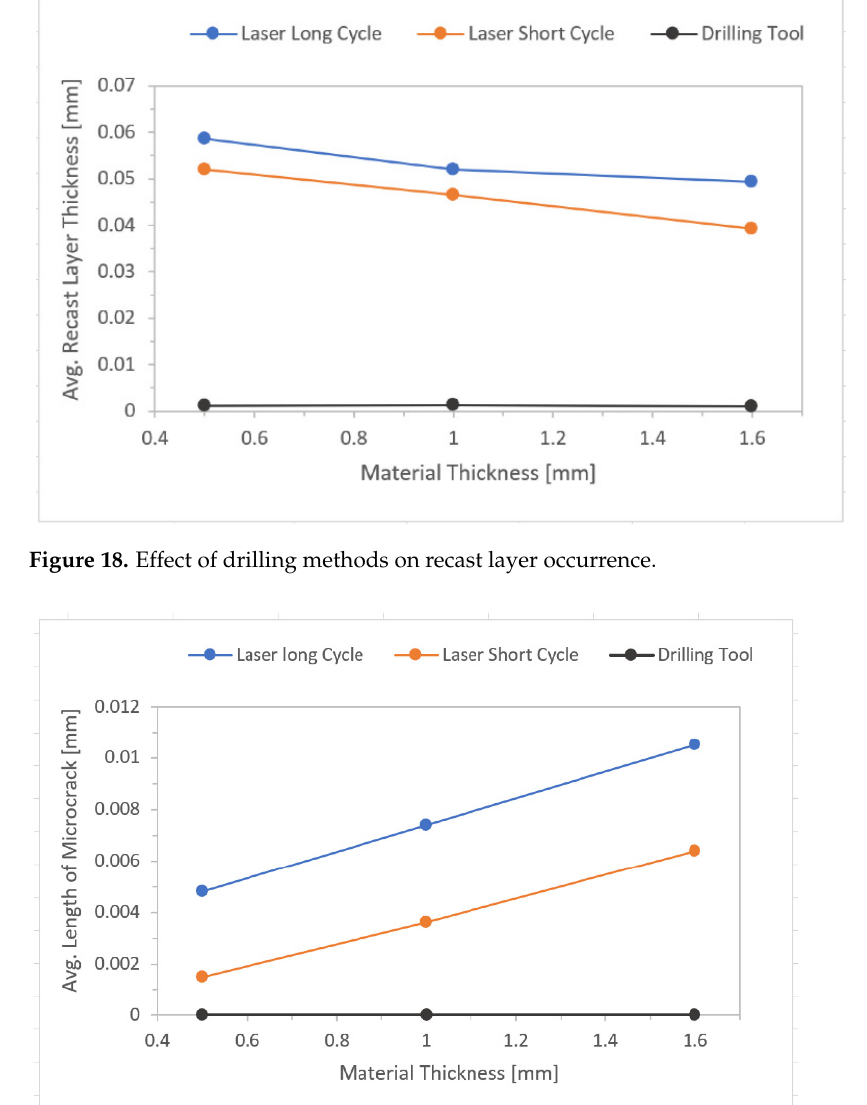
Figure 19. Effect of drilling methods on microcracks occurrence.